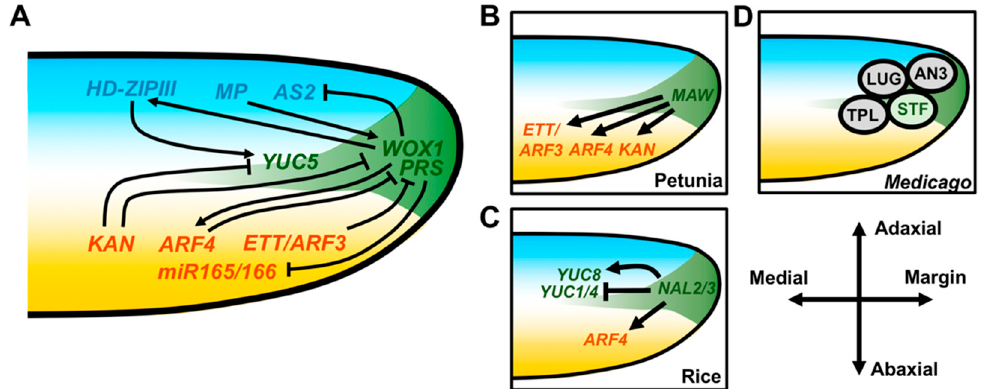
Figure 3. Genetic interactions between marginal and adaxial–abaxial patterning genes at the leaf margin. ( A ) WOX1 / PRS inhibits the expression of the adaxial patterning gene AS2 and the abaxial patterning genes miR165 / 166. Inhibition of miR165 / 166 indirectly promotes expression of HD-ZIPIII genes in the adaxial domain but may also do so via other direct / indirect mechanisms. KAN , ETT / ARF3 and ARF4 can repress WOX1 / PRS and WOX1 / PRS can promote ARF4 . Auxin biosynthesis at the margin is promoted by expression of the auxin biosynthesis gene YUC5 , which is inhibited by KAN and promoted by HD-ZIPIII . (B-D) WOX1 and PRS activity in other plant species. ( B ) The petunia homolog of WOX1 , MAW , promotes the expression of ETT / ARF3 , ARF4 , and KAN homologs. ( C ) In rice, the PRS orthologs NAL2 and NAL3 repress the expression of ETT / ARF3 and ARF4 homologs as well as the auxin biosynthesis genes YUC1 and YUC4 . YUC8 is instead upregulated by NAL2 / 3 . ( D ) The Medicago WOX1 protein STF can physically interact with the TPL and LUG corepressor proteins but also with the transcriptional activator AN3.